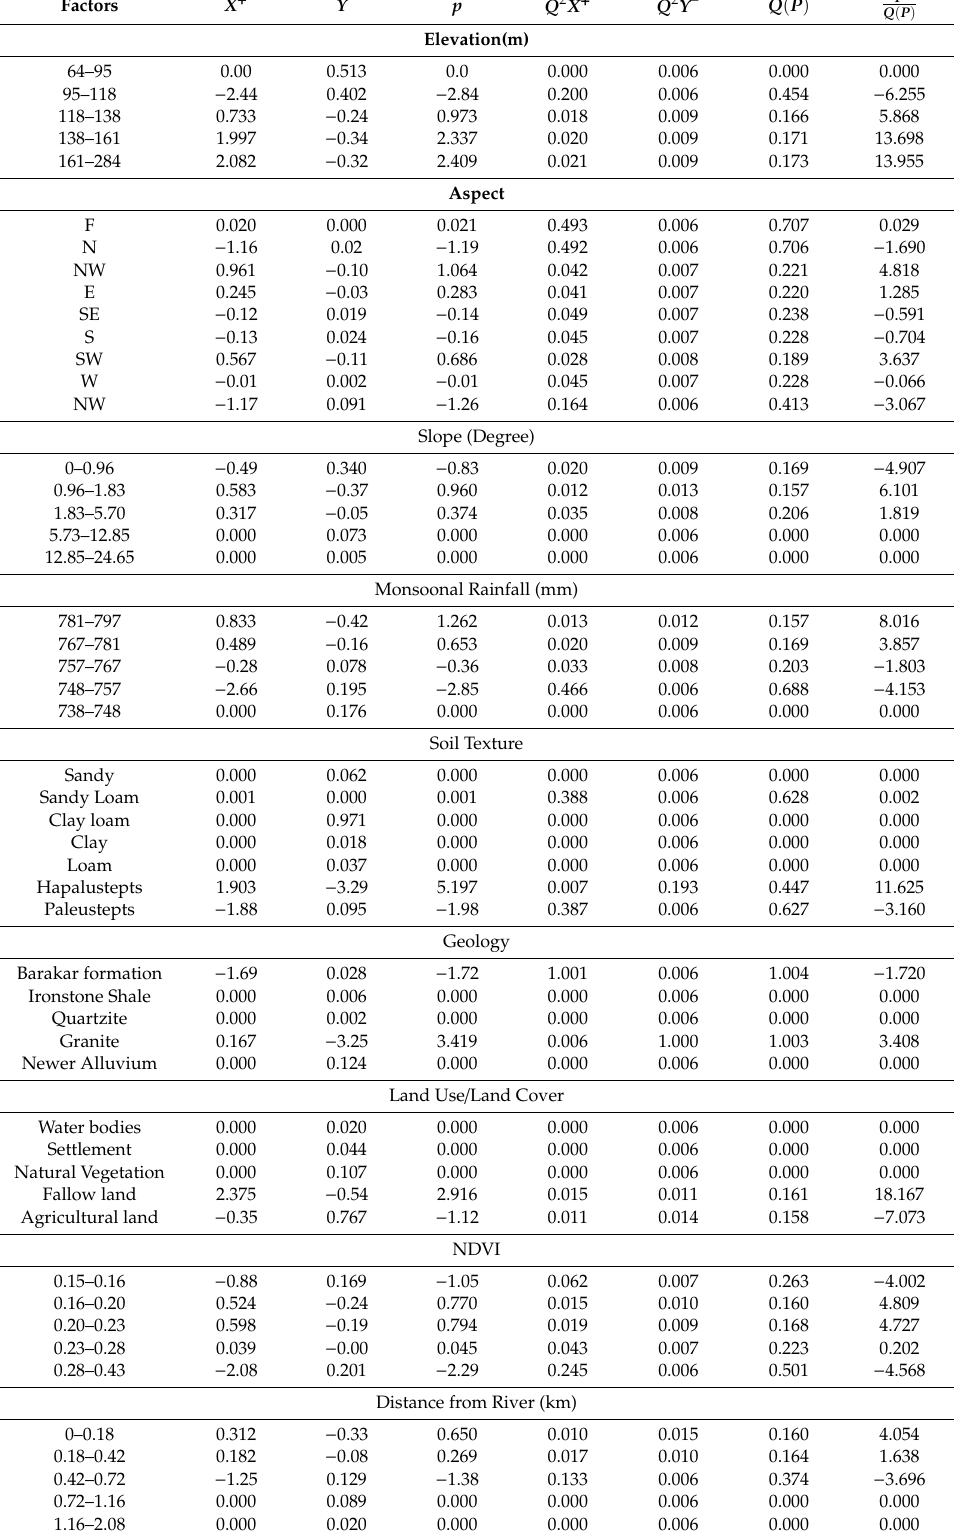
Table 3. Relationship between gully erosion and gully condition factors using the WofE